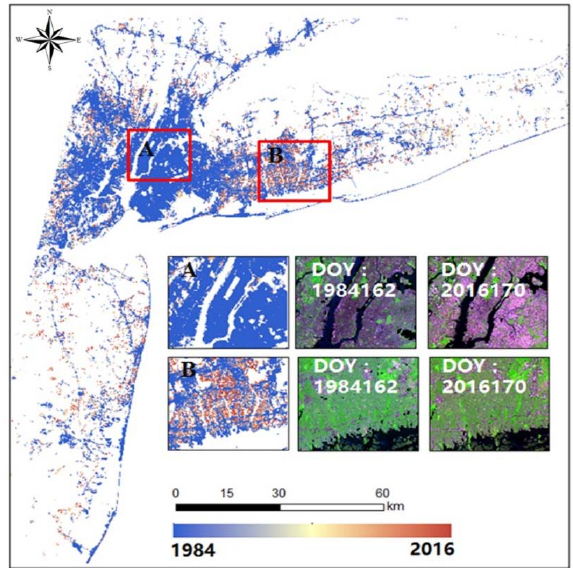
Figure 9. Urban expansion during 1984–2016 in New York, with insets providing magnified views of ( A ) Central Park and ( B ) Levittown. TM images corresponding to the beginning and end of the analysis period are also shown.